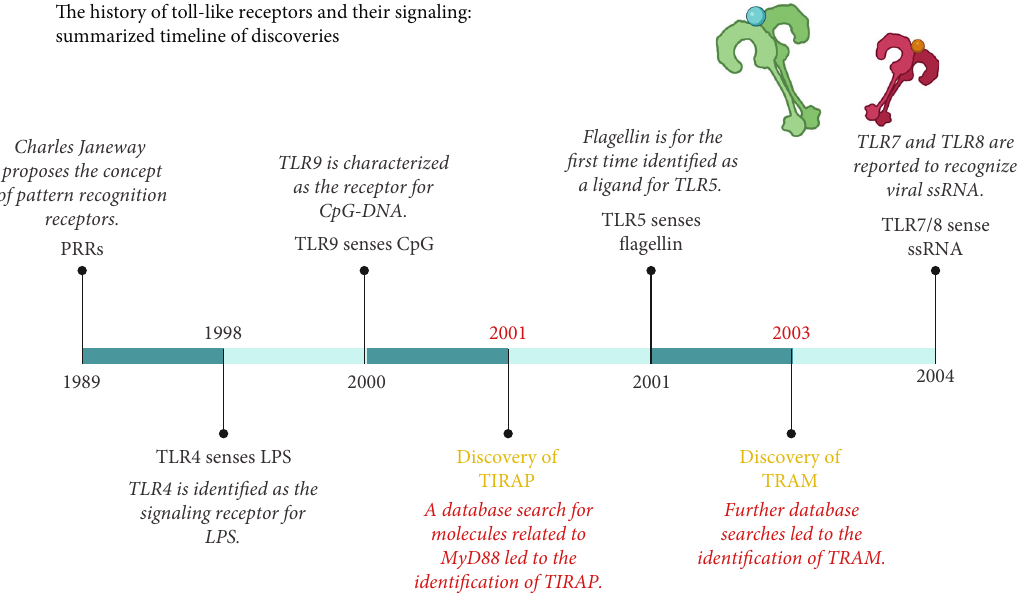
Figure 4: The history of Toll-like receptors and their signaling: summarized timeline of discoveries. Abbreviations: CpG-DNA: cytosine- phosphate-guanine-deoxyribo-nucleic acid; LPS: lipopolysaccharide; MyD88: myeloid di ff erentiation primary response 88; PRRs: pattern recognition receptors; ssRNA: single-stranded ribonucleic acid; TIRAP: Toll/interleukin-1 receptor domain-containing adaptor protein; TLR4/5/7/8/9: Toll-like receptor 4/5/7/8/9; TRAM: TRIF-related adaptor